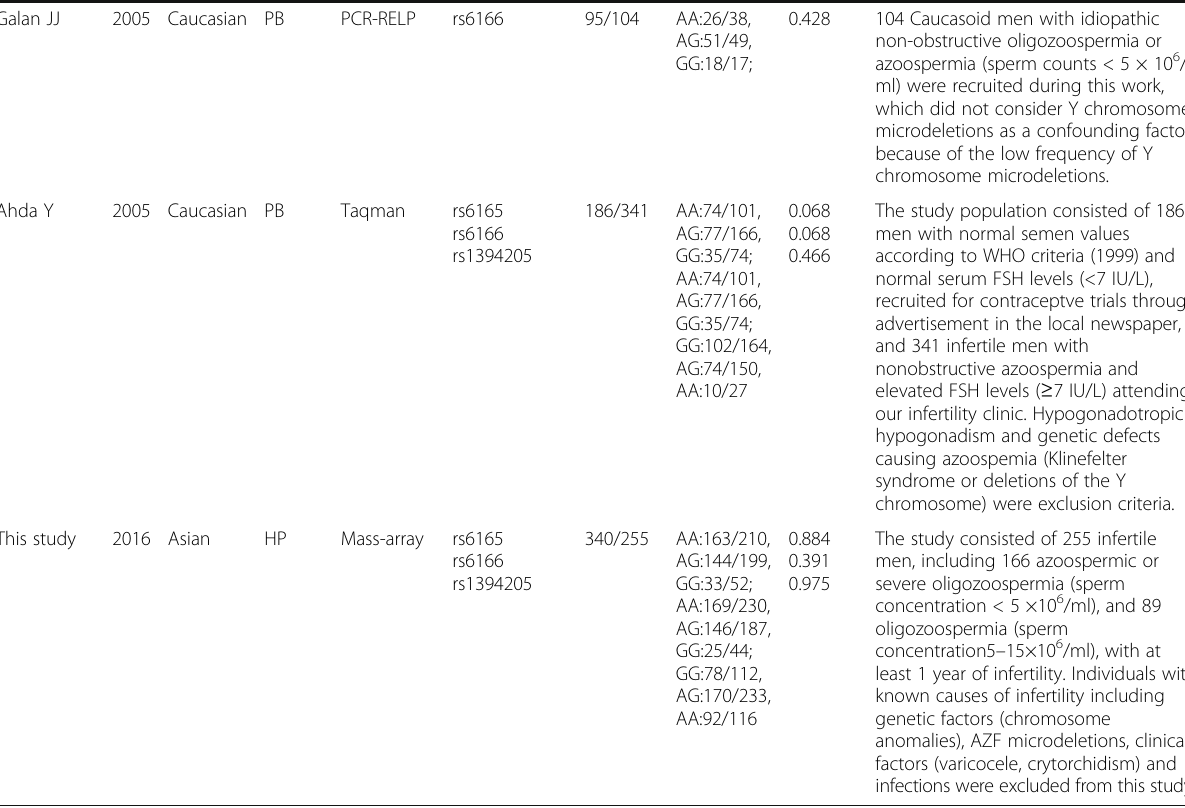
Table 4 Main characteristics of all studies on the genotype of FSHR rs6165, rs6166 and rs1394205 included in the meta-analysis (Continued) Galan